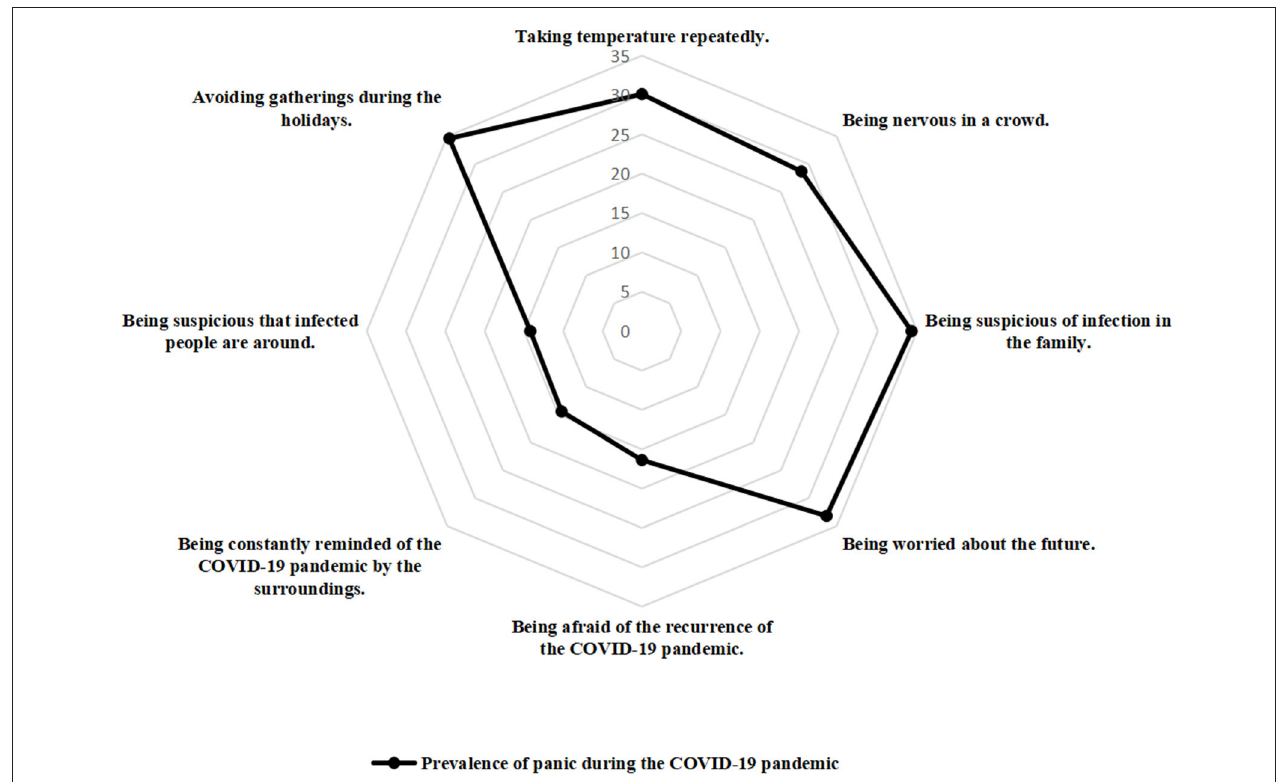
FIGURE 2 | The radar map of the distribution of the public panic (psycho-behavioral responses).